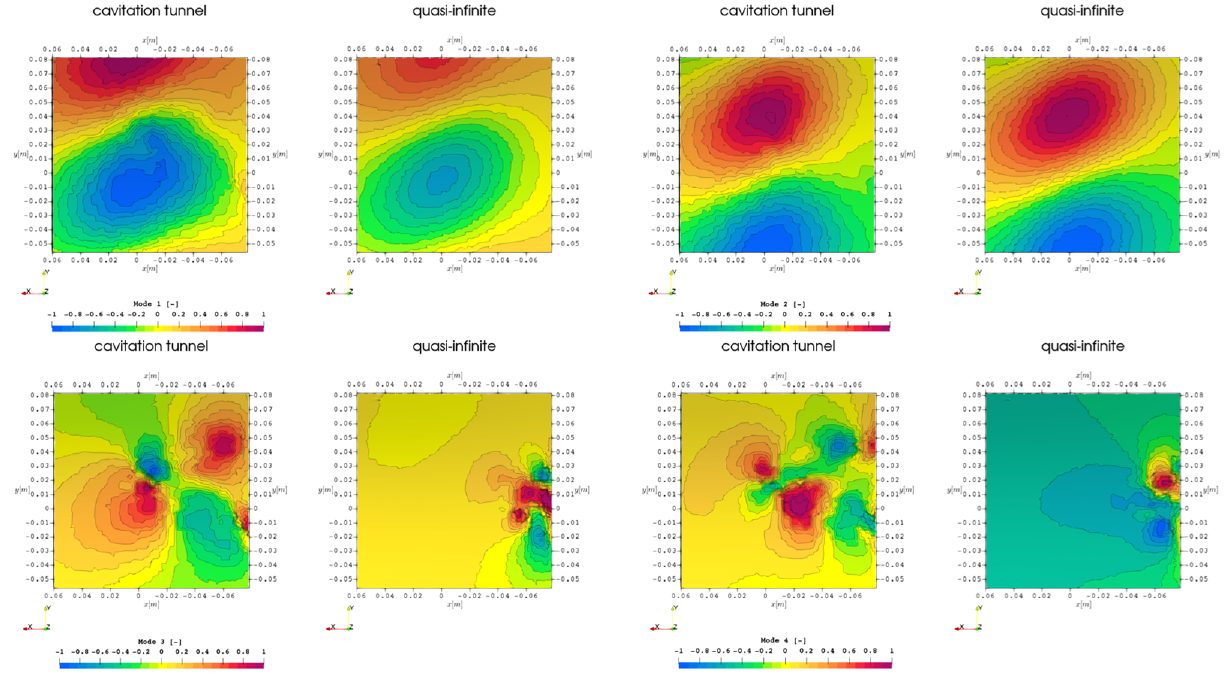
Figure 10. First 4 POD modes of pressure time data set on hull above propeller, comparison of domain extent, RANS.